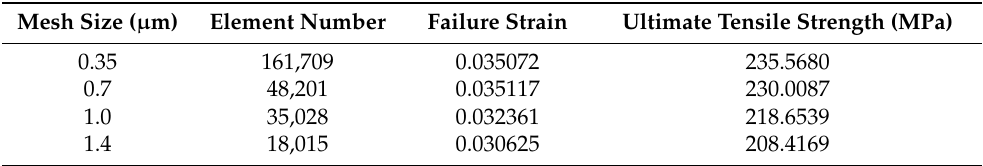
Table 1. Mesh size effect on the failure strain and ultimate tensile strength. Mesh Size ( µ